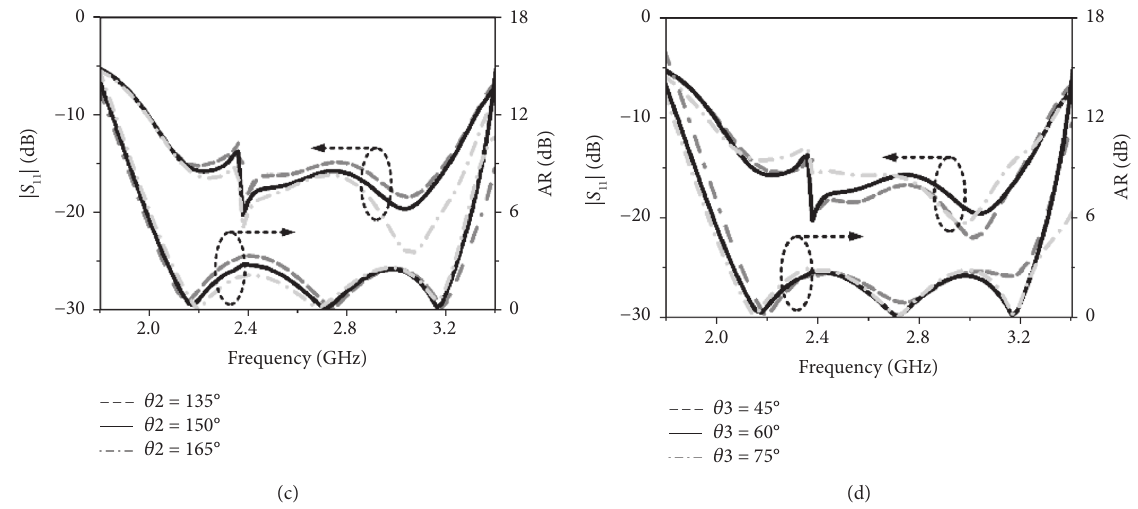
Figure 5: | S 11 | and AR curves of the designed antenna with different parameters: (a) W 1, (b) W 3, (c) θ 2, and (d) θ